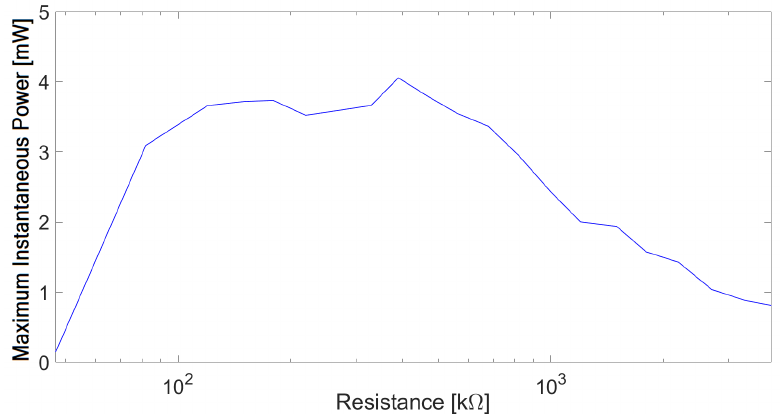
Figure 12. Maximum instantaneous power calculated for different values of R L .